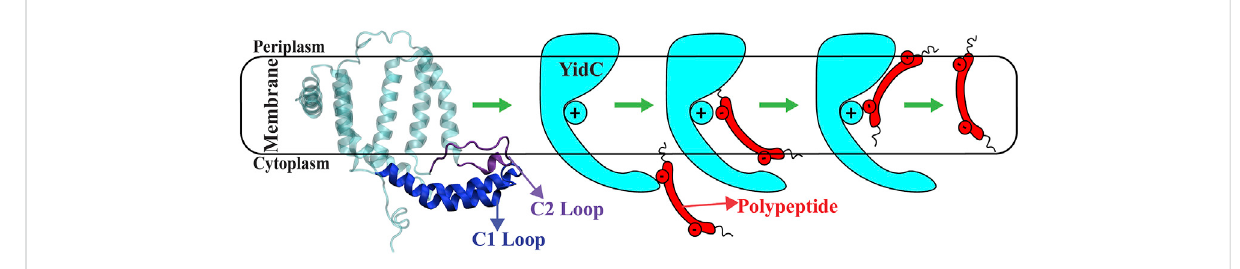
FIGURE 1 The cartoon representation of YidC and the schematic illustration of the SecY-independent insertion mechanism. A cartoon representation of YidC ’ s C1 and C2 loops on the cytoplasmic side (left). Schematic illustration of the YidC Sec-independent insertion of polypeptide (right).